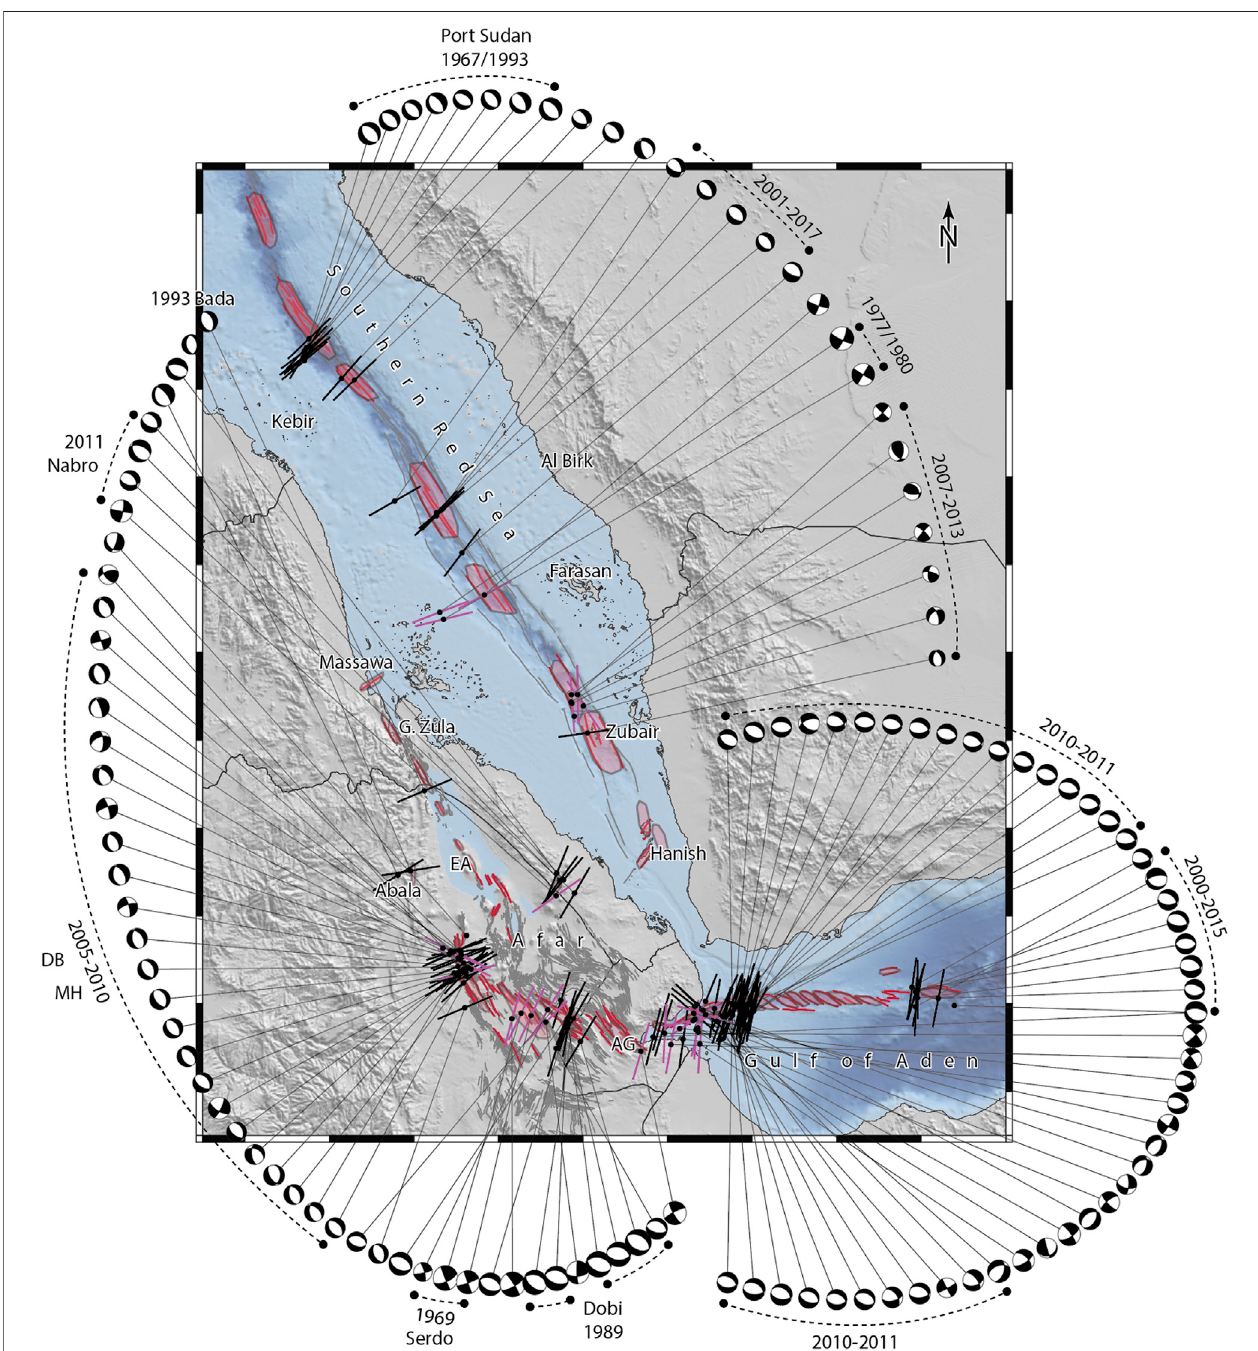
FIGURE 9 | Focal mechanisms (from Hofstetter and Beyth, 2003, and Global Centroid Moment Tensor project, GCMT, www.globalcmt.org, Dziewonski et al., 1981; Ekström et al., 2012) related to swarms in the SAGA region from 1960 to 2017 as sourced from the ISC Bulletin. Extension axes are shown by black segments (normal faulting) and pink segments (strike-slip faulting). Selected strong swarms are indicated by dates and area names (see main text for details). DB and MH for Dabbahu and Manda Hararo magmatic segments, respectively. Pink polygons and red lines represent the areas that have been affected by swarm activity (see Figure 8 for